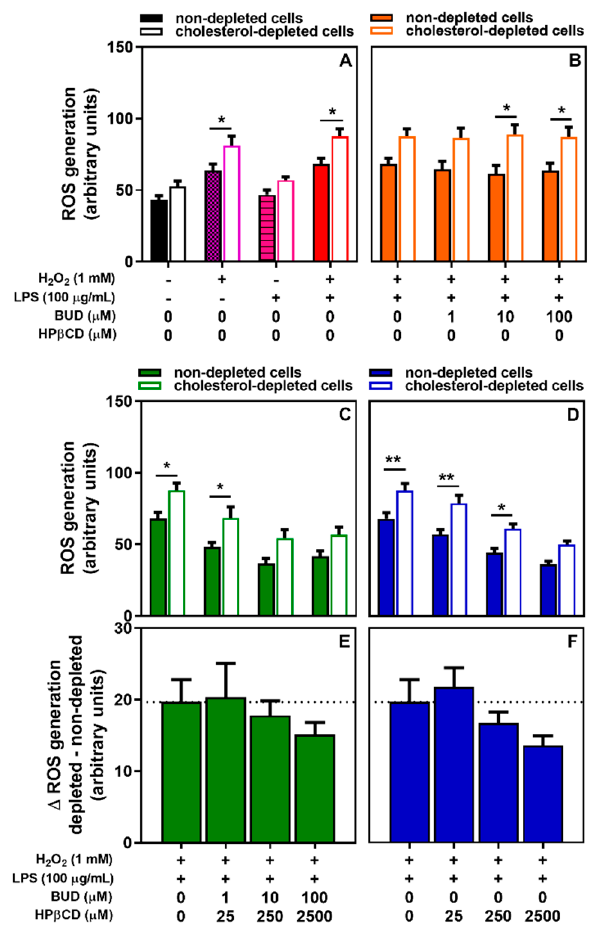
Figure 6. ROS generation in cholesterol-non-depleted or cholesterol-depleted A549 cells after treatment with H 2 O 2 , LPS, or H 2 O 2 + LPS for 2 h ( A ) and e ff ect of BUD ( B ), BUD:HP β CD complex ( C ) and HP β CD ( D ) on H 2 O 2 + LPS-induced ROS generation. Panels E and F show the di ff erence ( ∆ ) between the e ff ect observed in cholesterol-depleted and -non-depleted cells of BUD:HP β CD complex ( E ) and HP β CD ( F ) on H 2 O 2 + LPS-induced oxidant generation after treatment for 2 h. Each bar represents the mean ± SEM of 4 independent means of triplicated measures. H 2 O 2 + LPS-treated bar is the same for each panel. A one-way ANOVA with Dunett post-test was used to compare the mean of each test group in panels ( E , F ) with the mean of the H 2 O 2 + LPS-treated group. A two-way ANOVA with Tukey multiple comparison post-test was used to compare the mean of non-depleted group with the mean of cholesterol-depleted group in the same concentration (panels A – D ). The di ff erence was considered significant for a p -value < 0.05. (*) and (**) indicate, respectively, p < 0.05 and 0.01 between non-depleted and cholesterol-depleted group (panels A – D